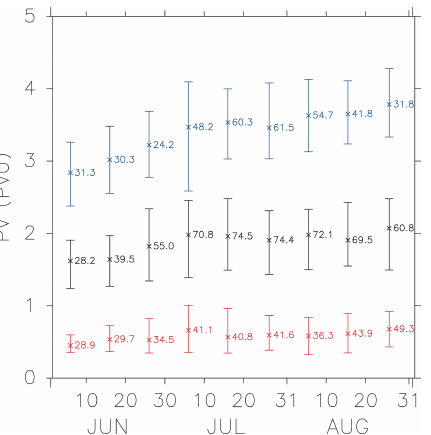
Figure A2. Statistics for the daily barrier PV values, determined ob- jectively by the method of Ploeger et al. (2015), using ERA-Interim reanalysis data from 1979 to 2016. The horizontal axis is the time of year, with nine time ranges corresponding to the early, middle, and late periods of each month between June and August. Red, black, and blue lines respectively show the results for the 360, 370, and 380K levels. Vertical lines show the range of PV values between 15th and 85th percentiles, with crosses in the middle corresponding to the median values. The numbers next to the crosses represent cor- responding percentages of the cases when the barrier is successfully